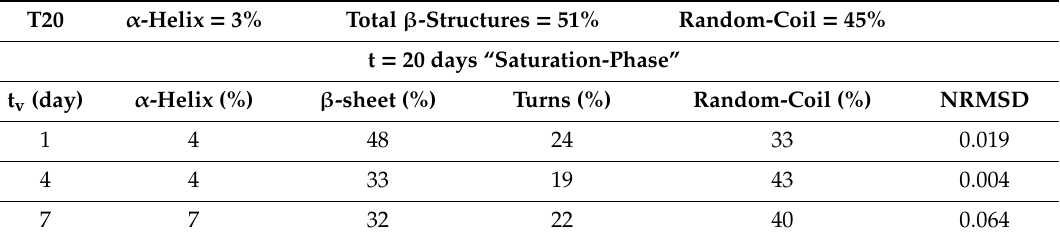
Table 4. Percentage of secondary structures obtained by the fitting procedure, relative to spectra of Figure 7.